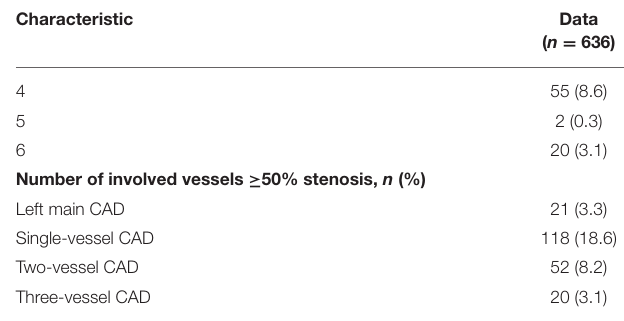
TABLE 1 | Clinical and coronary CT angiography (CCTA)